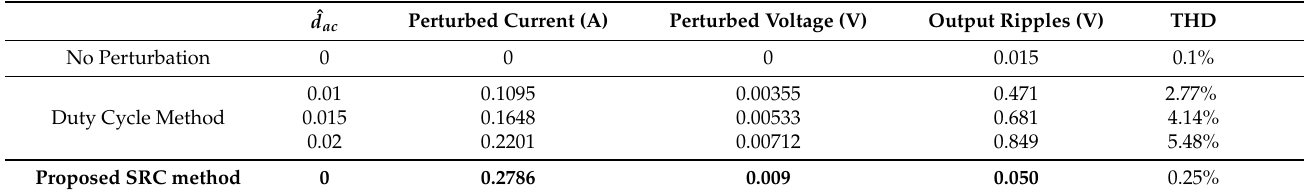
Table 2. Battery perturbation signals’ and output voltage ripples’ comparison.